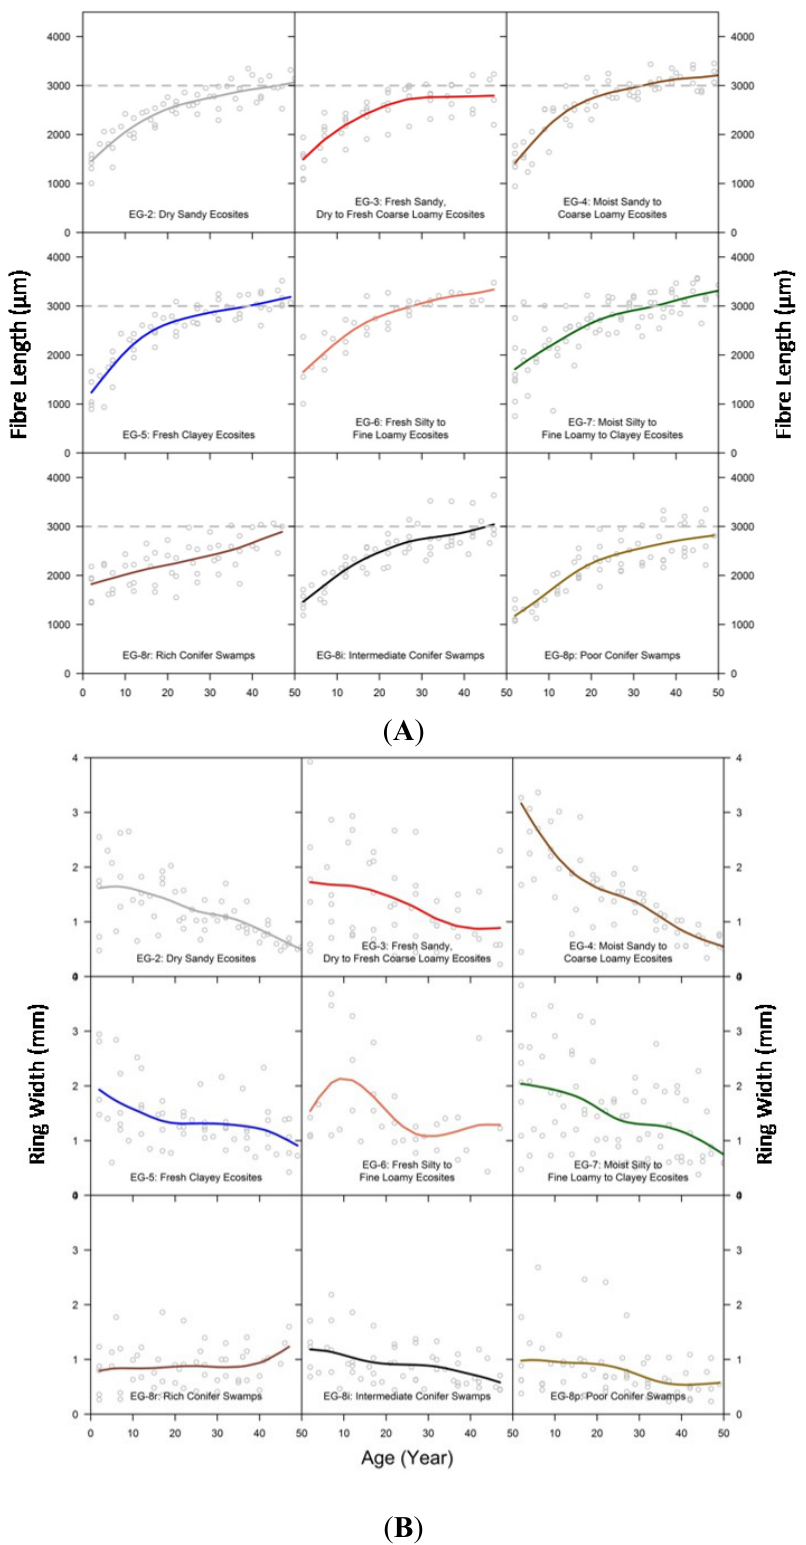
Figure 5. ( A ) Fibre length response curve (mean fibre length against age at breast height); ( B ) Regional growth curve (ring width measurements against age at breast height) from black spruce increment cores representing different ecosite groups collected from the boreal forest of north eastern Ontario from